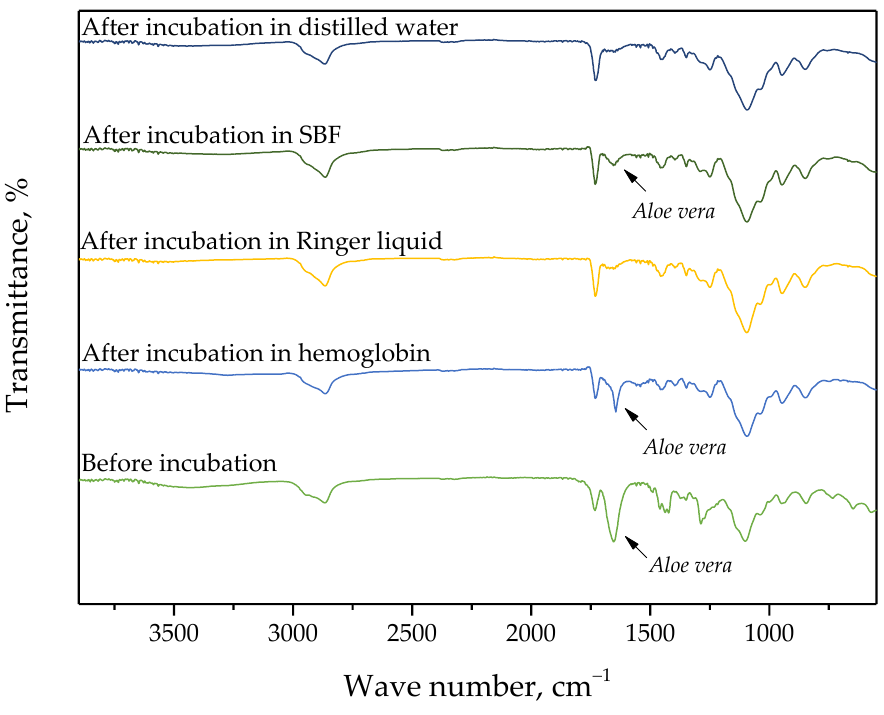
Figure 4. FT-IR spectrum of sample 0.025/Photo.